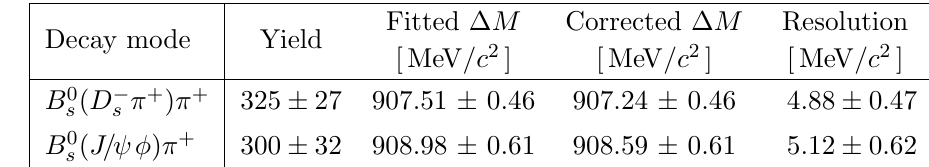
Table 2. Signal yields, mass di(cid:11)erence ((cid:1) M ) and resolution as obtained from (cid:12)ts shown in (cid:12)gure 2, together with the values corrected for the e(cid:11)ects of (cid:12)nal-state radiation and selection as described in the text. The uncertainties are statistical